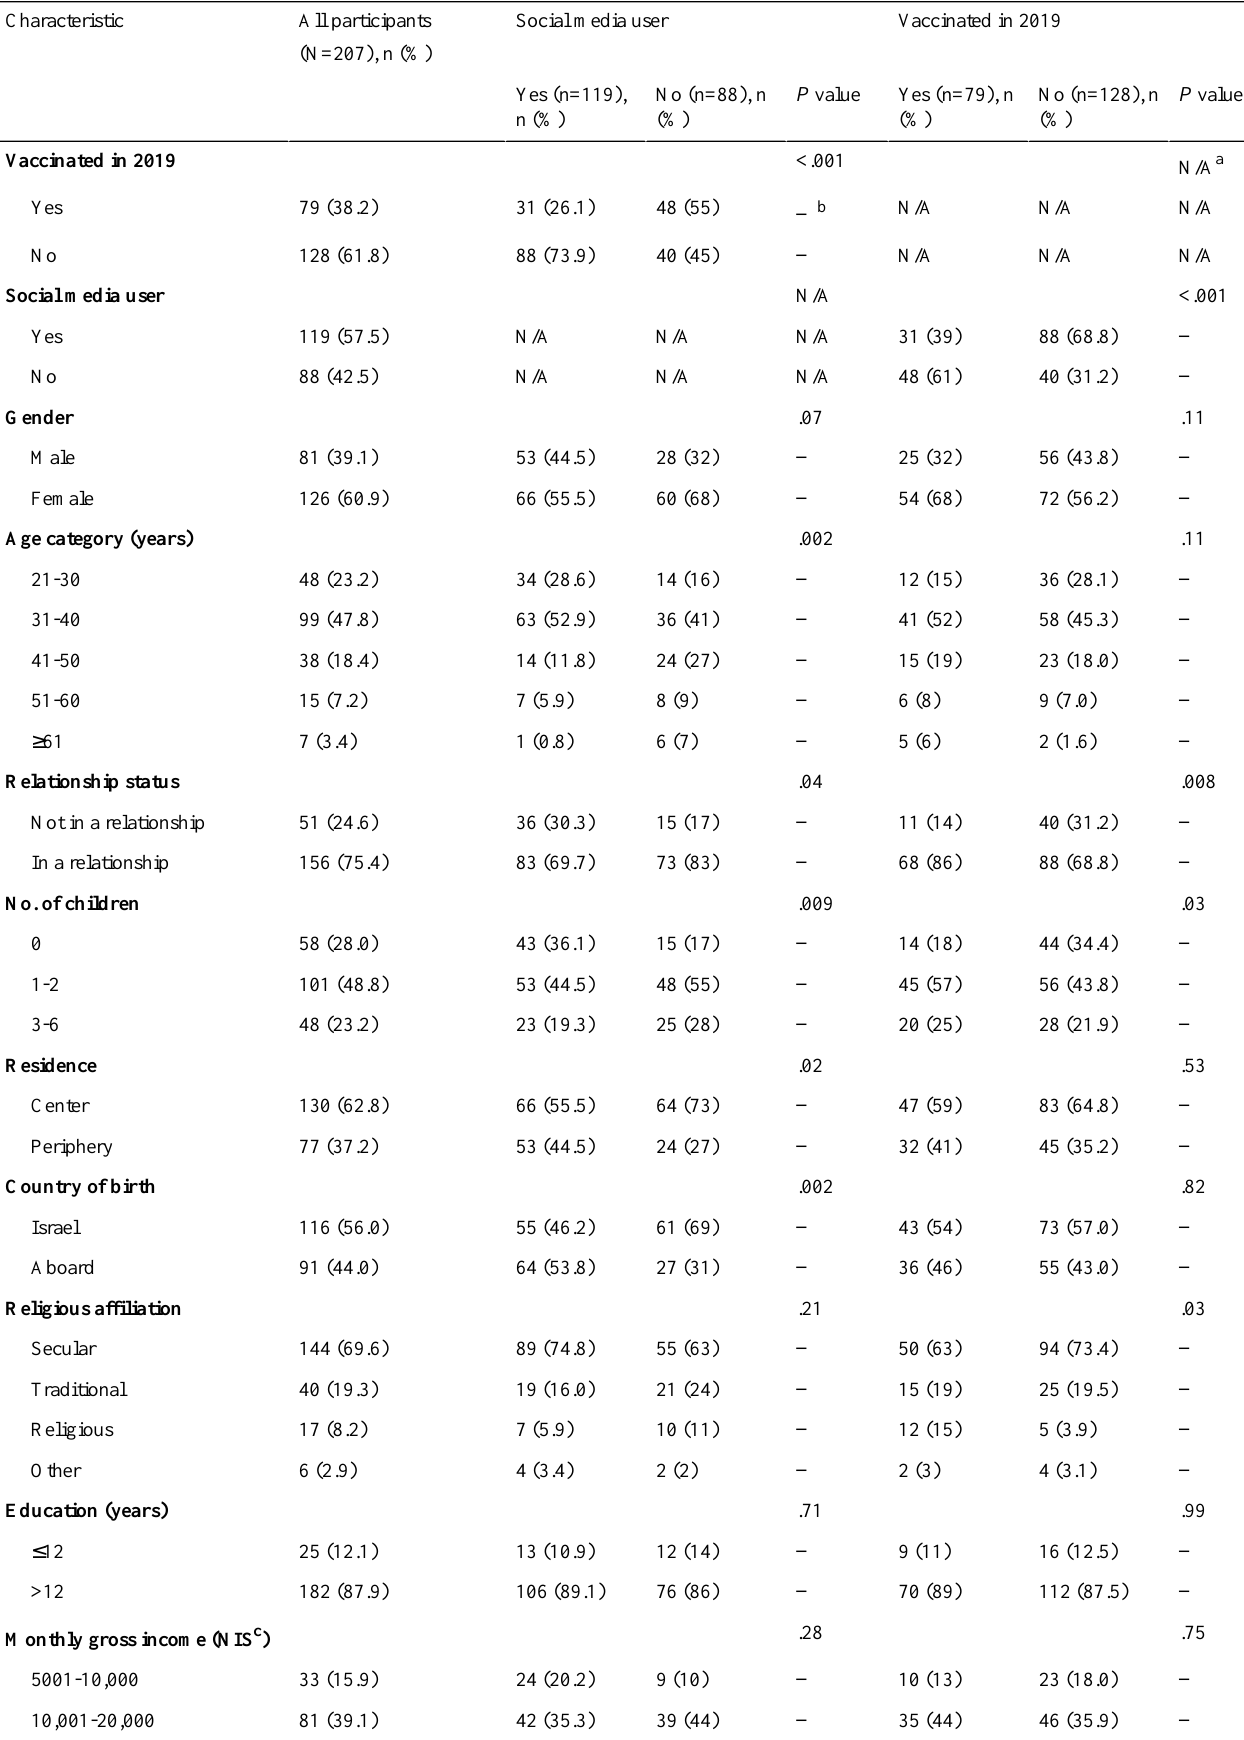
Table 1. Sociodemographic characteristics of the survey population.